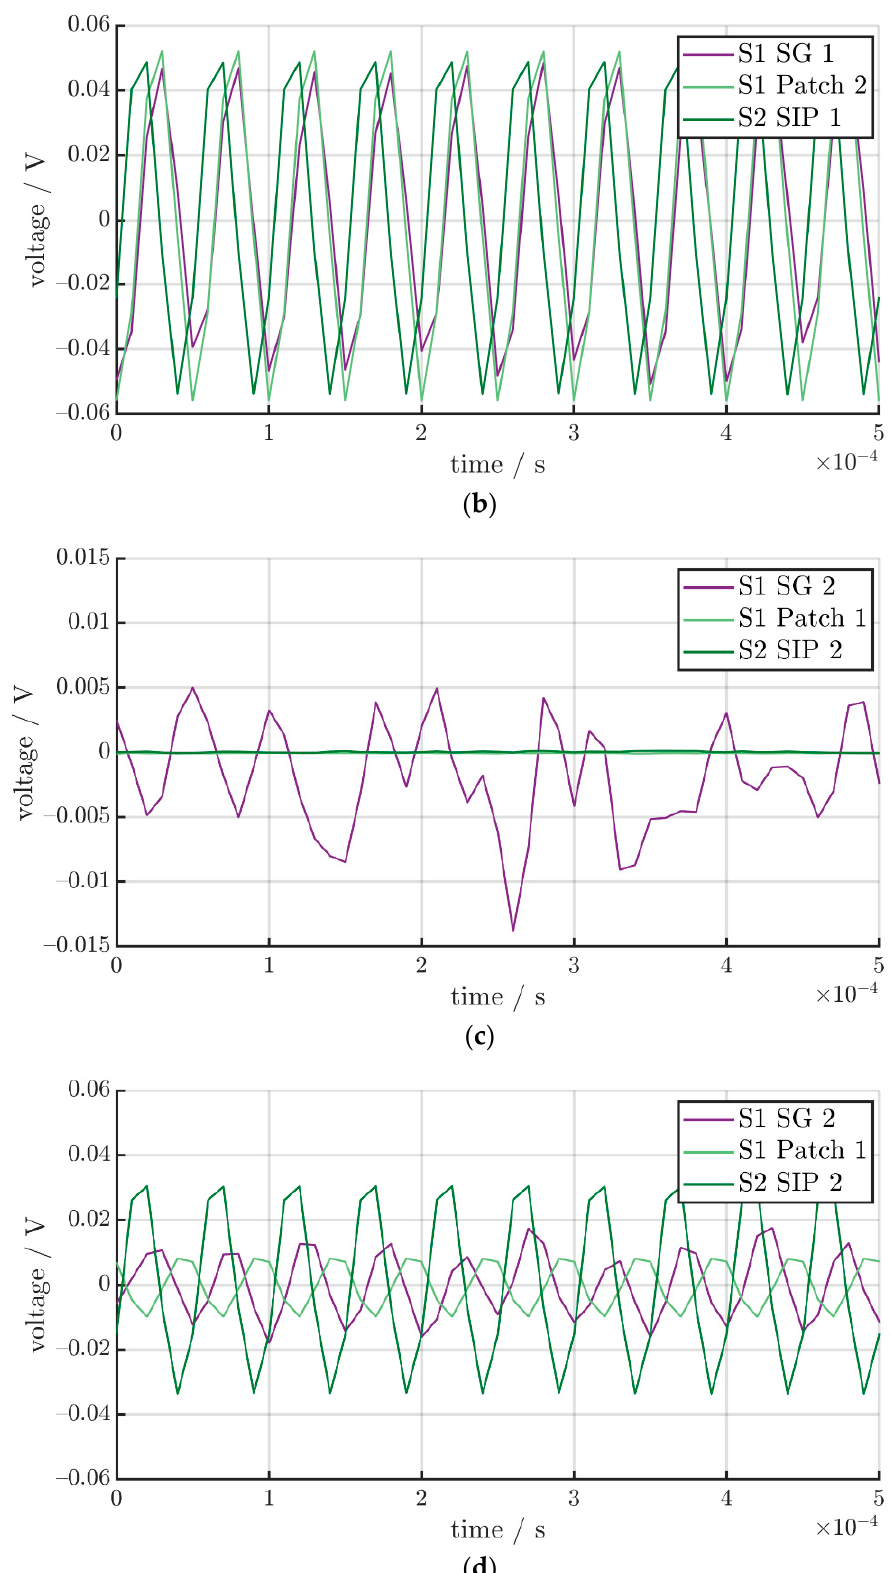
Figure 8. Noise and measured signals of: ( a ) Noise of all sensors with a parallel alignment in relation to the actuator; ( b ) Measurement signal of all sensors with a parallel alignment at 20 kHz ( c ) Noise of the sensors with a perpendicular alignment ( d ) Measurement signal of all sensors with a perpendicular alignment at 20 kHz.